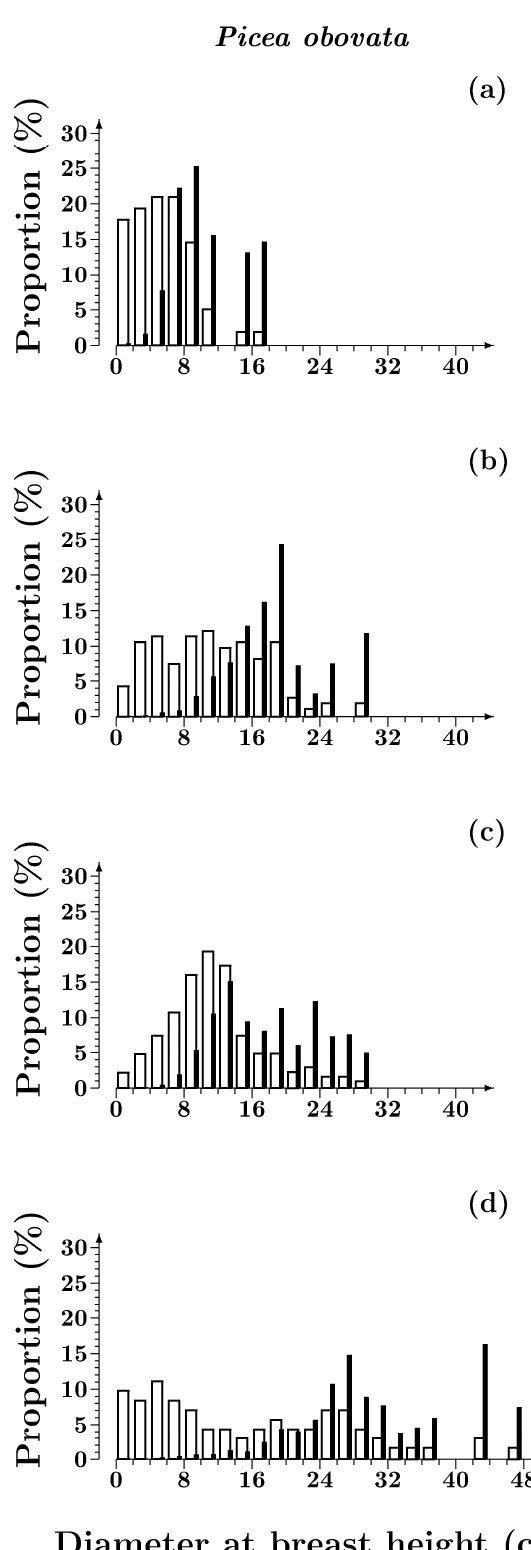
Figure 2. Diameter class distributions of Picea obovata trees in Siberian spruce forests with post-fire periods of 80 ( a ), 150 ( b ), 220 ( c ) and 380 ( d ) years. Open bars—by number of individuals; solid bars—by volume.